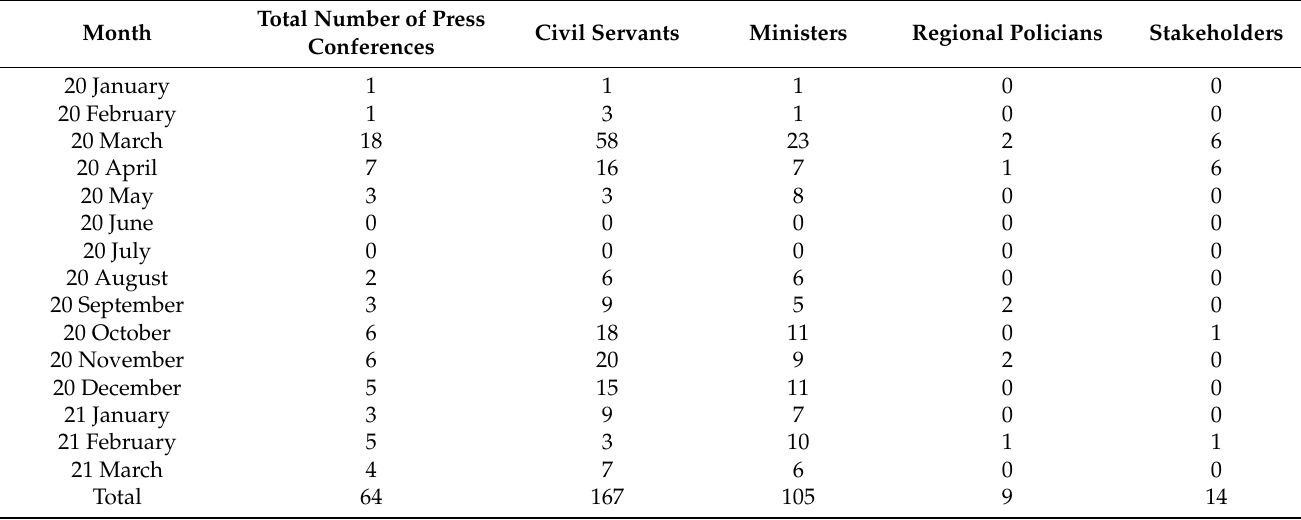
Table 2. Press conferences between January 2020 and March